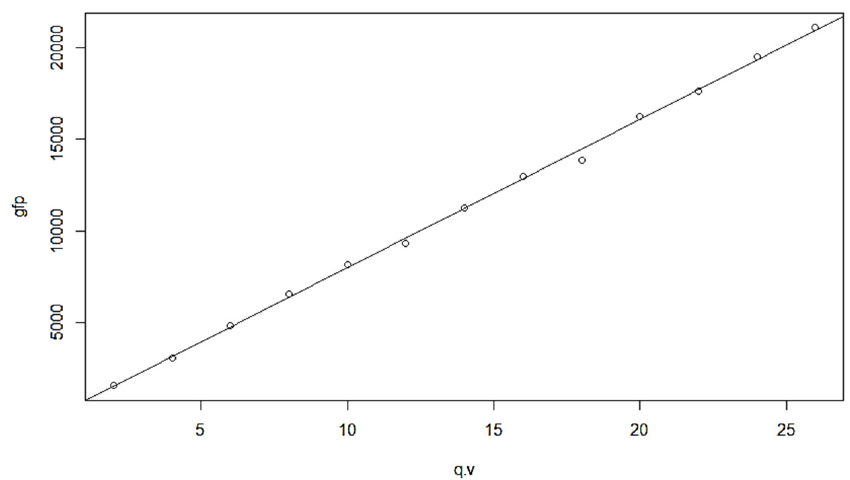
Figure A4. Fitness function for the example described in the Appendix A.